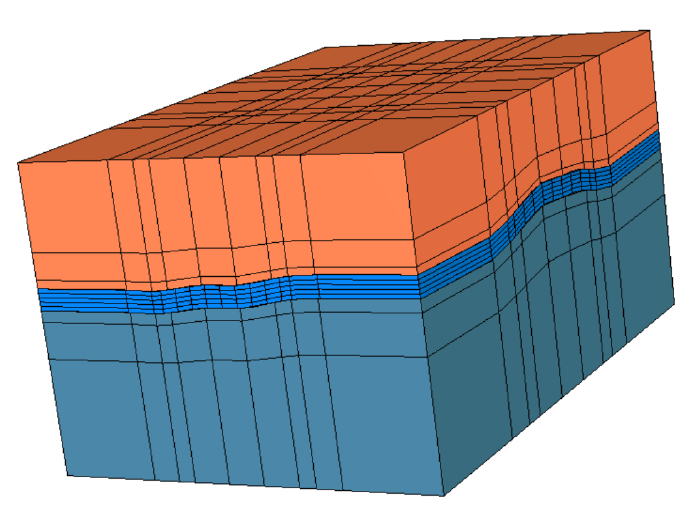
Figure 1. Nonconforming discretization by